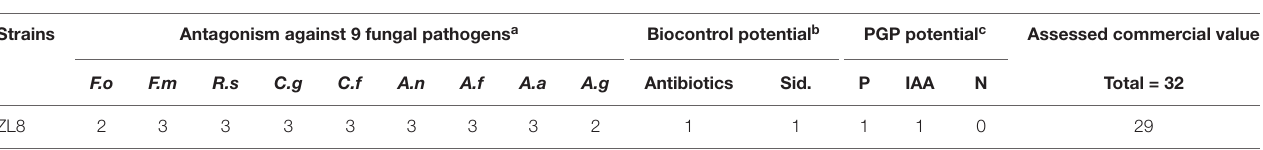
TABLE 3 | Assessed potentials of ZL8 as biocontrol and PGPR agents.